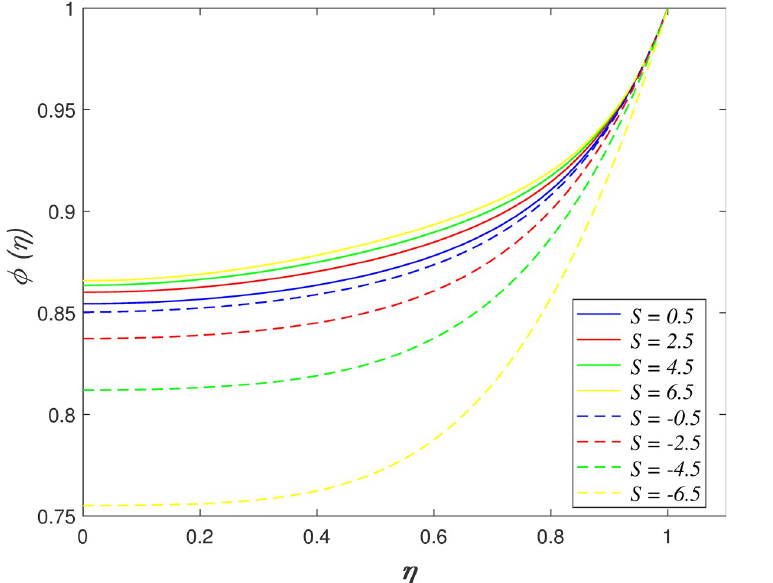
Fig 5. Impact of S on